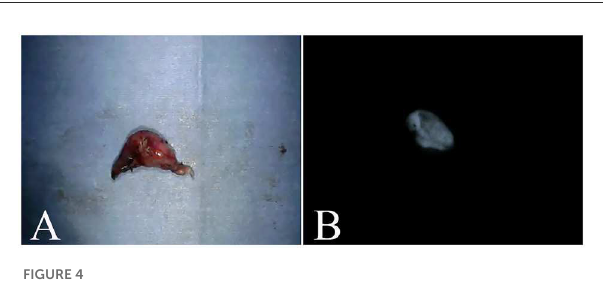
FIGURE4 Excised tracheobronchial lymph nodes. (A) is a tracheobronchial lymph node from a case of metastasis from a malignant epithelial tumor. (B) is the fluorescent image of a similar lymph node, with confirmed fluorescence.